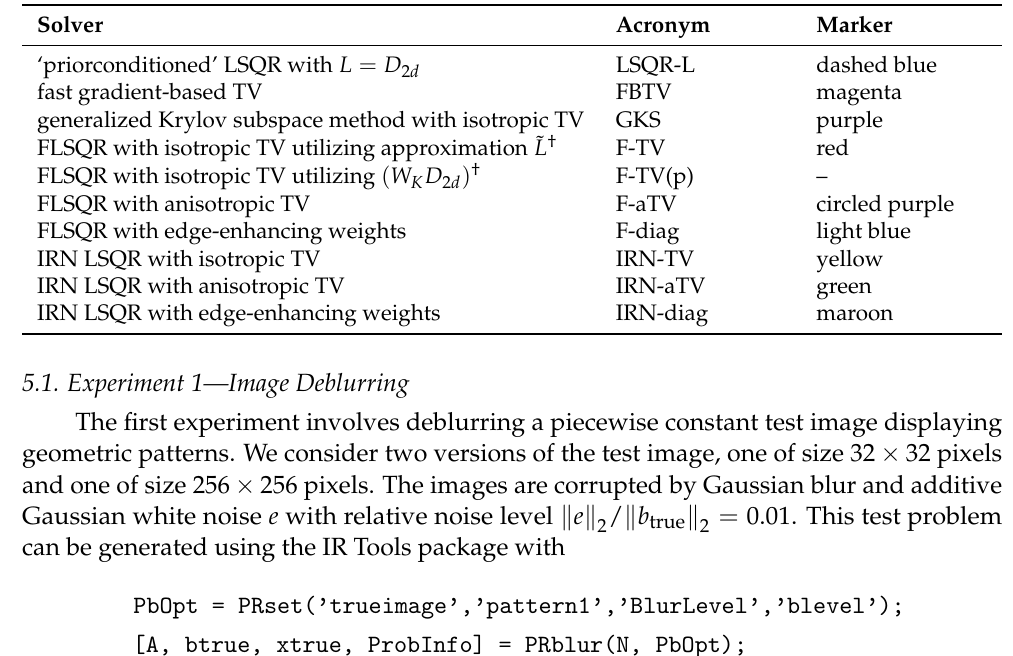
Table 1. Summary of the acronyms denoting various solvers considered in Section 5, and coherent marker and color codes used in most of the